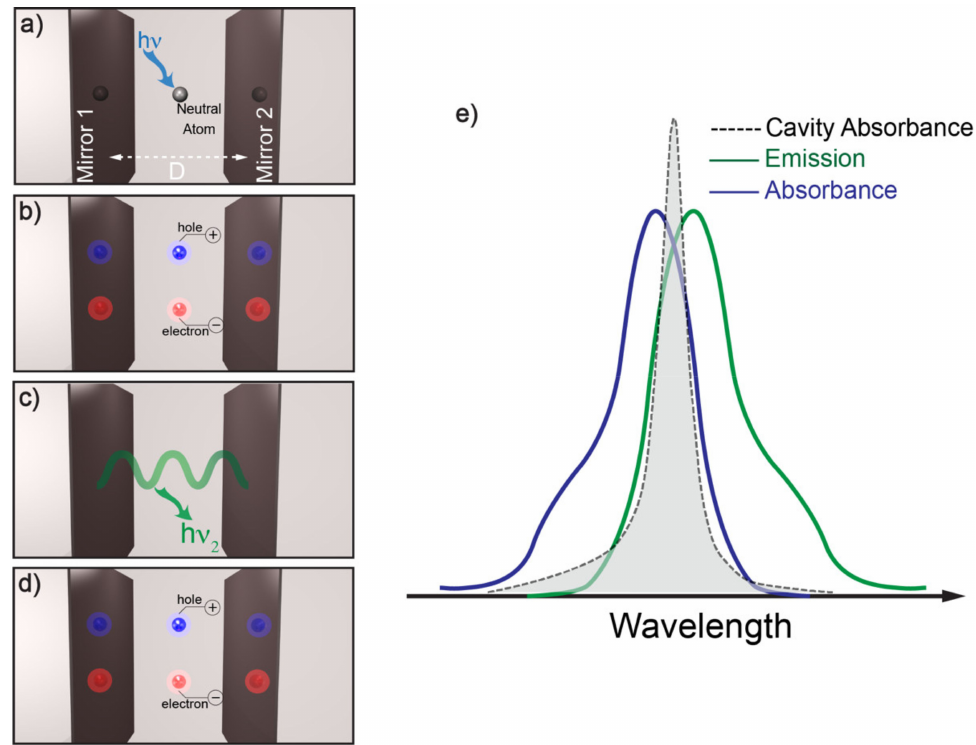
Figure 1. Sketch of the feedback mechanism at the basis of cavity–atom strong interaction . ( a ) Atom or molecule in its ground state placed between a classic Fabry–Perot cavity made of two mirrors facing each other, displaced by a distance D. If a photon with energy hv suitable to promote the atom or the molecule to an excited state interacts with the atom or molecule, an exciton is formed ( b ). The exciton can radiatively relax by emitting a photon with energy hv 2 very close to that of the exciton. The exciton can be stored in the cavity for many roundtrips (according to the Q-factor of the cavity) as a standing wave ( c ). Provided a low-Stokes-shift molecule, the photon stored in the cavity can be re-absorbed by the molecule and excite another exciton ( d ). ( e ) A proposed spectral configuration to optimize the cavity–atom interaction. Here, the cavity absorbance spectrum is designed to cover the spectral region in which the absorbance and the emission of the gain molecule